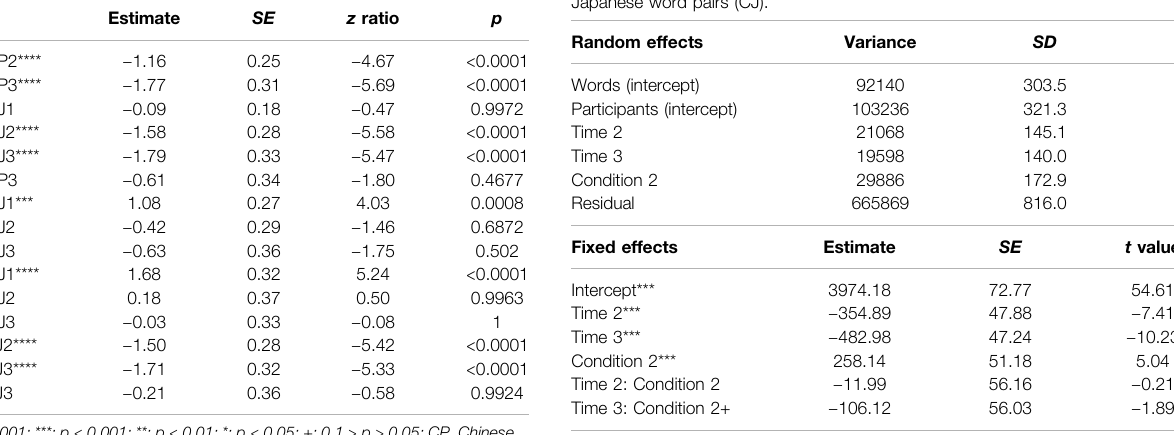
TABLE 5 | Results of the linear mixed effects model for response times of correct answers in Chinese word and picture pairs (CP) and Chinese word and Japanese word pairs (CJ).